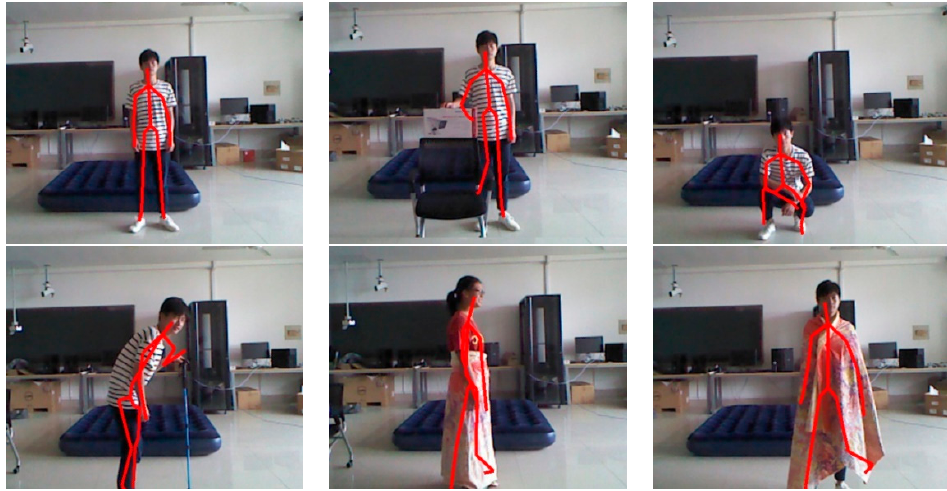
Figure 8. The detected skeletons with different postures, clothes or walking devices.